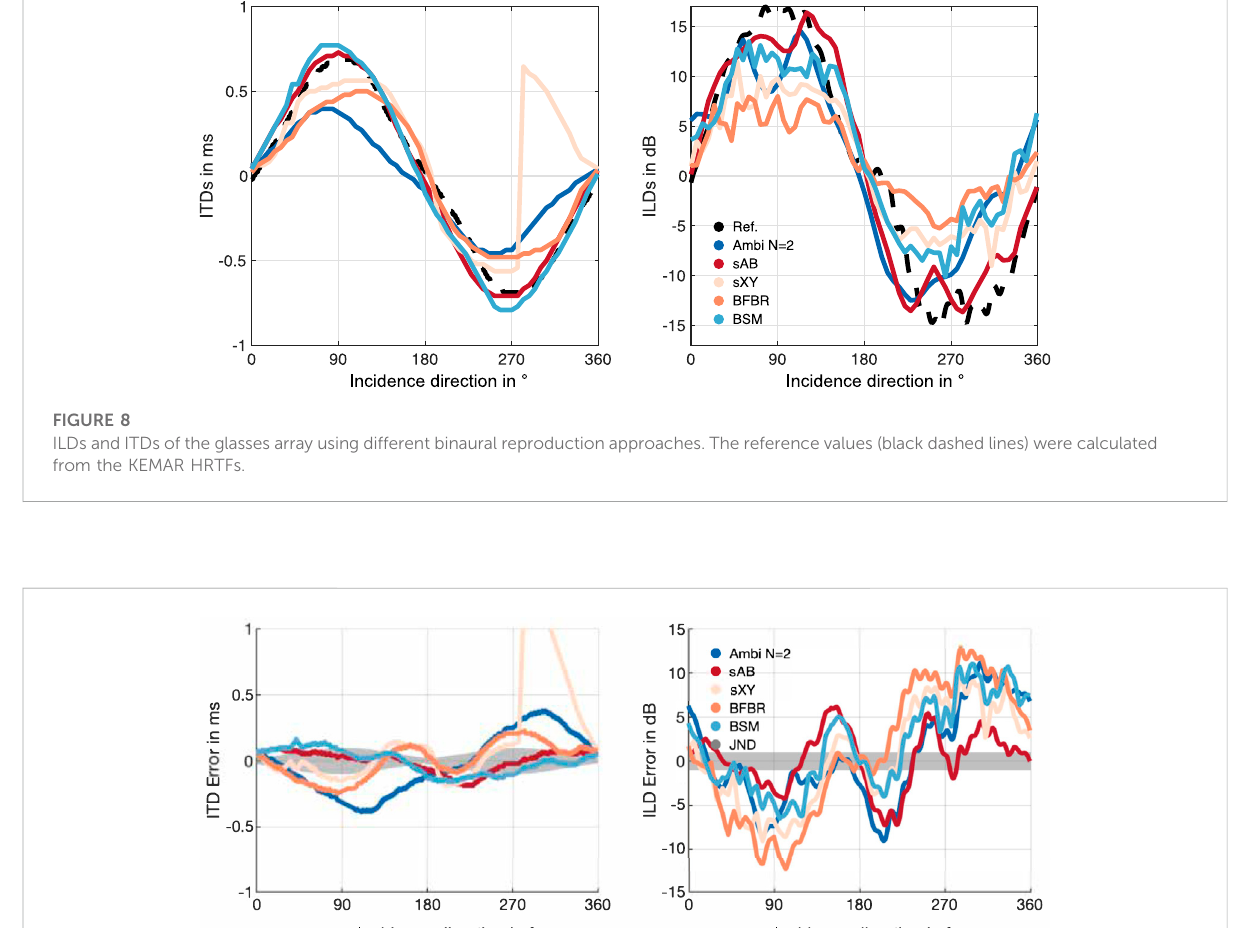
Frontiers in Signal